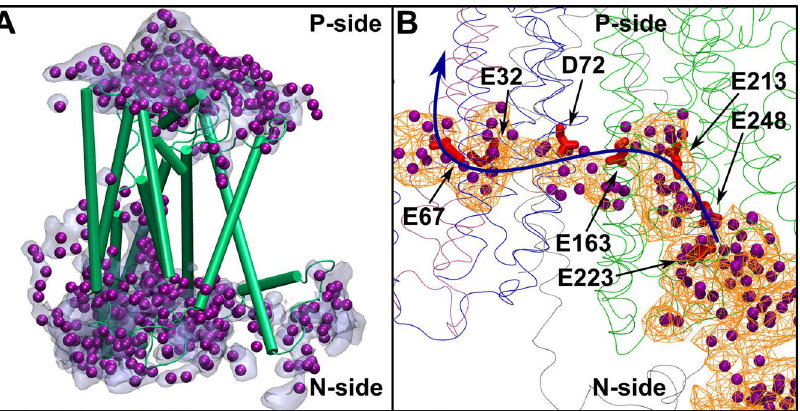
Figure 5. Hydration of the Nqo8 subunit ( A ). Amino acid residues (Glu223, Glu248, Glu213, Glu163 of Nqo8, Glu32, Glu67 of Nqo11, Asp72 of Nqo7 in red) and water molecules (in purple) connect the Q-tunnel with the membrane-bound subunits ( B ). The blue arrow indicates a putative proton pumping route. Water occupancy is plotted with an isovalue of 0.2 ( A ) and 0.1 ( B ). The figure is prepared from simulation setup X in which Glu248, Glu213, Glu163 of Nqo8, and Asp72 and Asp74 of Nqo7 are protonated. In panel A, only water molecules within 4 Å of Nqo8 subunit (green) are shown. In panel B, Nqo7, Nqo8, Nqo10 and Nqo11 are colored grey, green, blue and mauve, respectively, and shown as thin ribbons (see also Supplementary Fig.